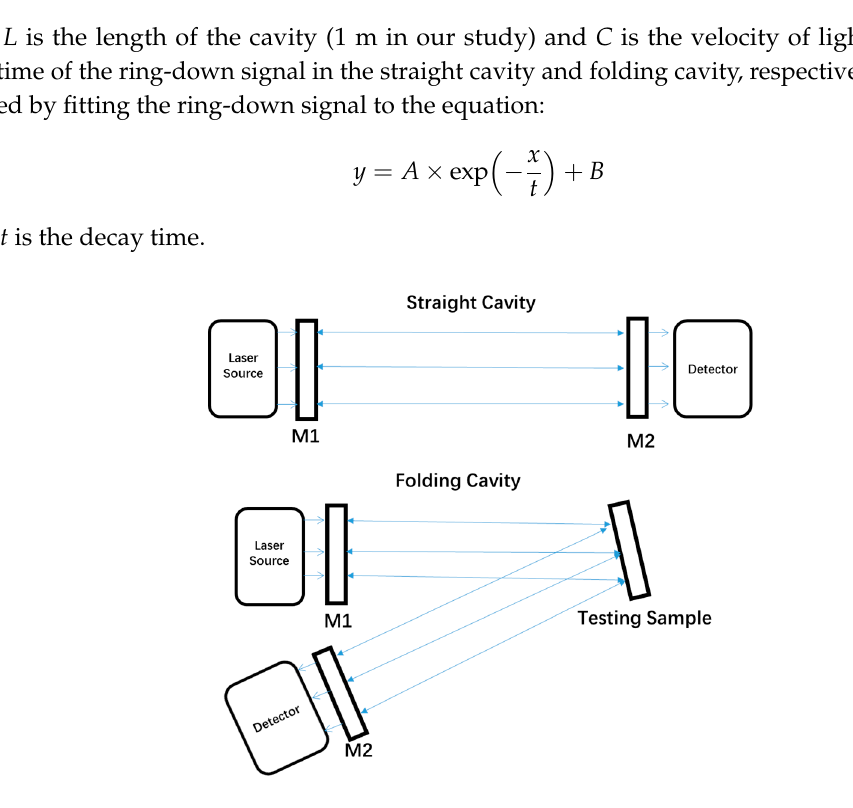
Figure 2. Schema of cavity ring-down spectroscopy.